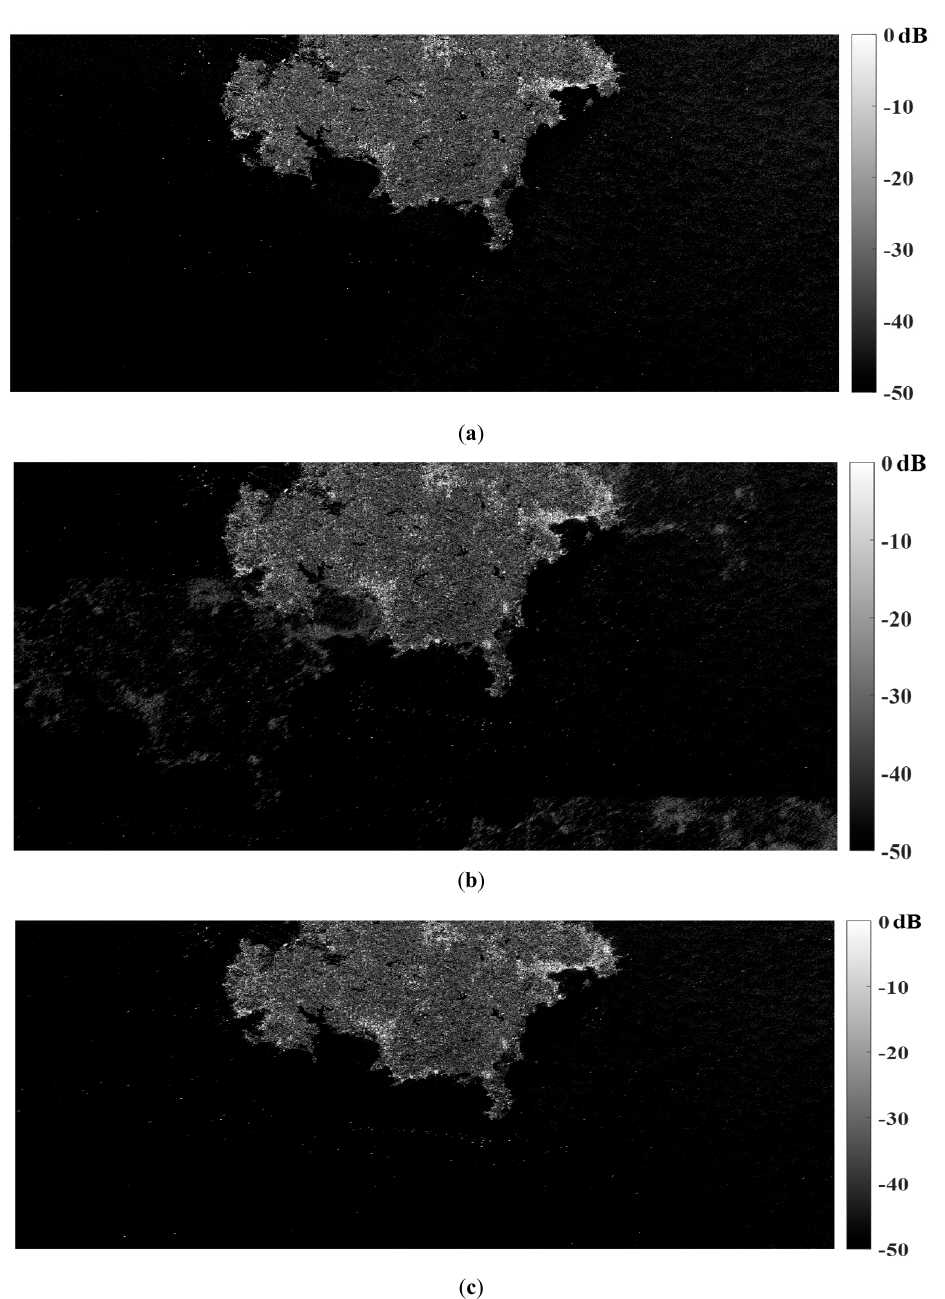
Figure 17. Distributed target simulation experiments of the focused Sentinel-1 SLC SAR image. ( a ) Focused SLC SAR image for simulation; ( b ) imaging result handled by the conventional recon- struction approach based on CHRE; ( c ) imaging result handled by the proposed approach based on AHRE.